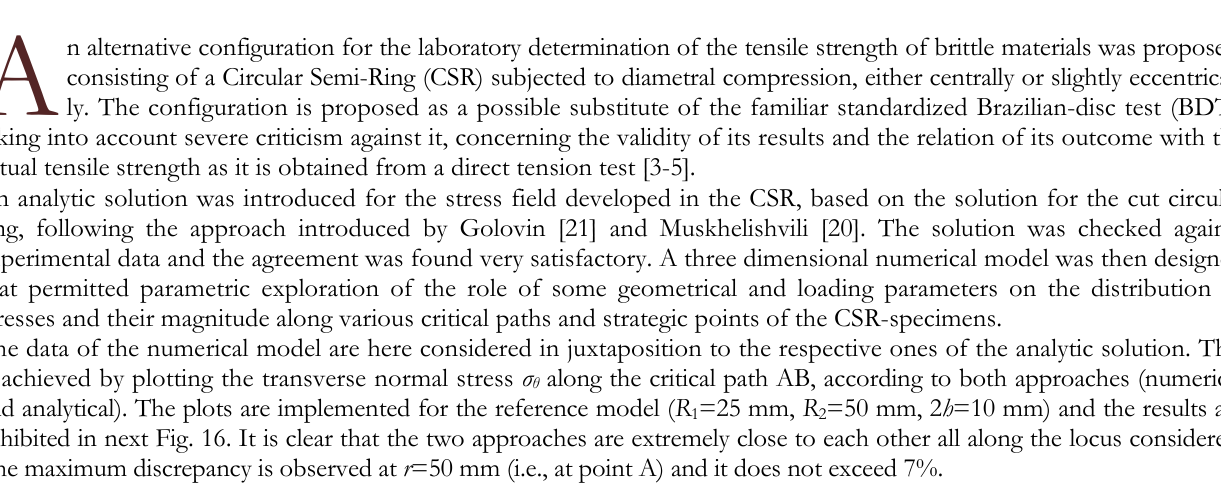
D ISCUSSION AND CONCLUDING